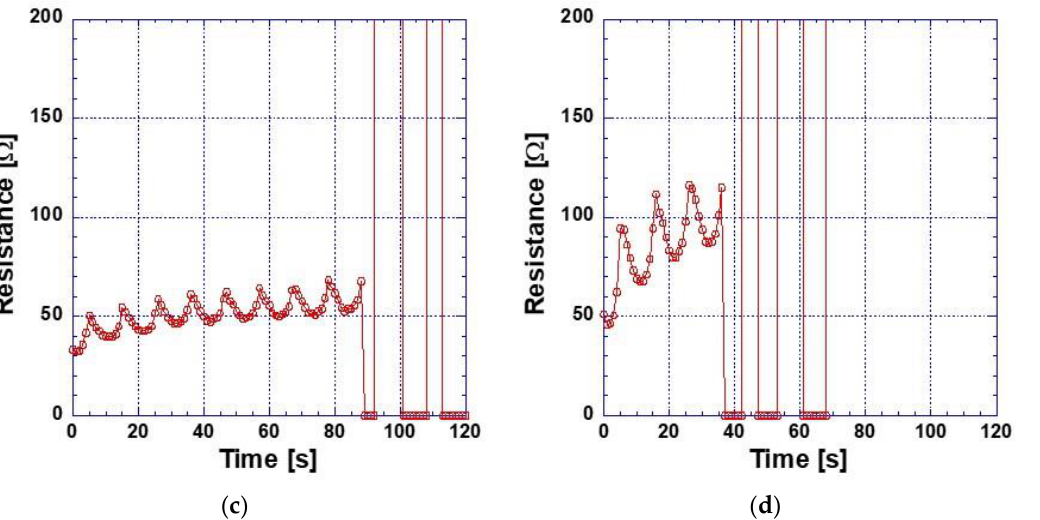
Figure 4. In situ resistance change of Ag NWs electrode on variously pre-stretched silicone rubber film during a cyclic test with 10 times repetition applying 20% strain; ( a ) 10% pre-stretched; ( b ) 20% pre-stretched; ( c ) 30% pre-stretched; and ( d ) 40% pre-stretched. Figure 5 represents the ratio change of R stretched /R released of Ag NWs electrode with pre-stretching percent of silicone rubber film at first cycle. At pre-stretching 10%, the value of R stretched /R released applying 10% strain was approximately 3 times higher than that of R stretched /R released applying 20% strain. As increasing pre-stretching strains, the difference of R stretched /R released applying 10 and 20% strain decreased. At pre-stretching 30%, the value of R stretched /R released was minimum. At pre-stretching 40%, R stretched /R released began to increase. In the case of R stretched /R released of Ag NWs without pre-stretching was 7 at 10% strain. The resistance of Ag NWs was not changed much in the stretched state.